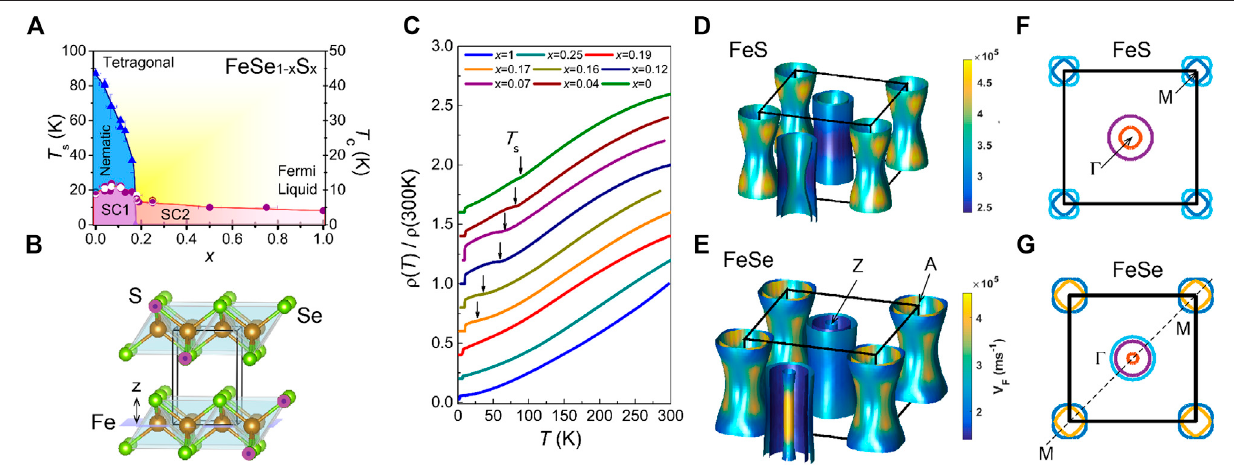
FIGURE 1 | Phase diagram of FeSe 1 − x S x . (A) Phase diagram of FeSe 1 − x S x based on Ref. 27. (C) The resistivity vs. temperature of FeSe 1 − x S x normalized at room temperature, after Refs. 27 – 29. The data are shifted vertically and the arrows indicate the position of the nematic transition that coincides with the tetragonal to orthorhombic transition at T s . This transition is better visualized using the fi rst derivative of the resistivity, as discussed in Refs. 27, 28, 30. (B) The tetragonal unit cell of FeSe 1 − x S x (solid lines). FeSe 1 − x S x crystalizes in the P 4/ nmm space group (No.129) with atoms Fe: 2a (3/4,1/4,0) and Se: 2c (1/4,1/4, z Se ). The position of the chalcogen above the Fe plane is indicated by the parameter z that affects signi fi cantly the band structure. Calculated Fermi surface using density functional theory (DFT using GGA approximation and spin-orbit coupling) of FeS in (D) and FeSe in (E) using experimental lattice parameters at room temperature for FeSe [31] and FeS [32, 33]).TheFermisurfacesarecoloredusingtheFermivelocitiesindicatedbythecorrespondingcolorbar.ThemiddleholebandwithlowervelocityinFeSehasadominant d xy character whereas the other hole and electron bands have mixed d xz/ yz character. The high-symmetry cut of the Fermi surface in the Γ -M plane ( k z (cid:2) 0) for FeS in (E) and FeSe in (F) . The dashed line indicates the direction of the high symmetry cuts in ARPES measurements.